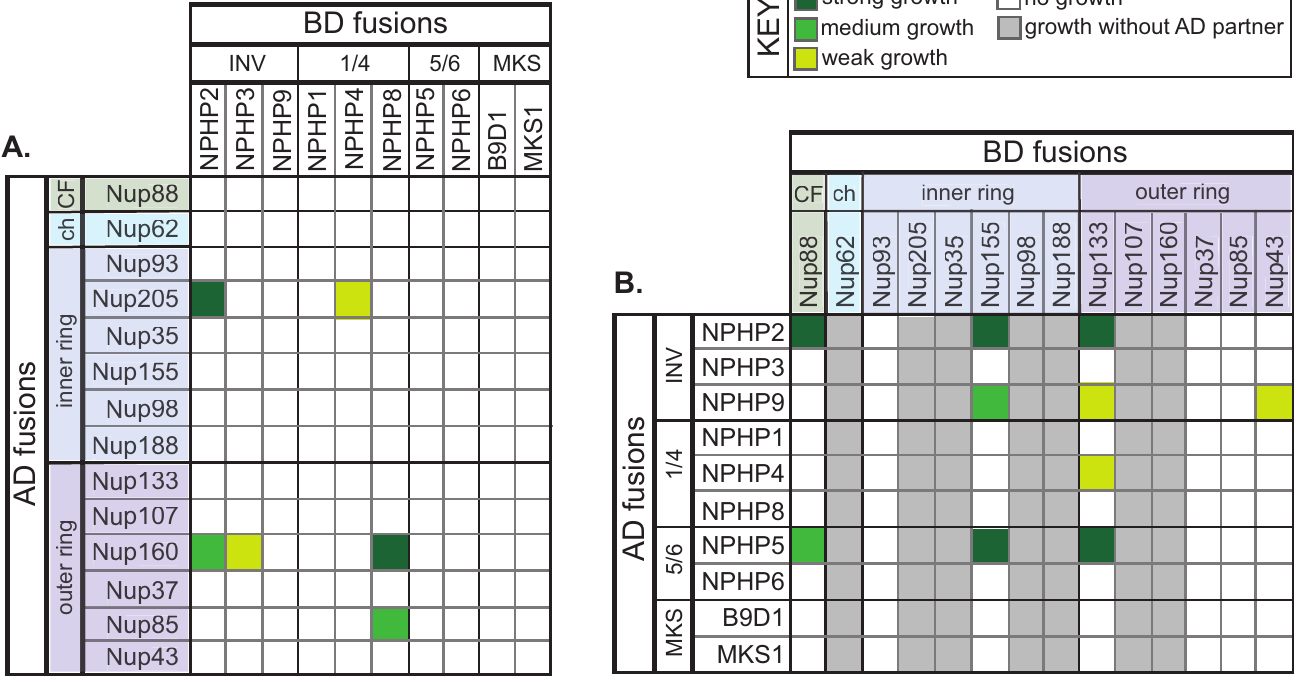
Fig 3. Directed yeast two-hybrid assay reveals NUP-NPHP interactions. The indicated transition zone proteins (INV, NPHP1/4, NPHP5/6, MKS complexes) and nucleoporin proteins were fused to a DNA binding domain (BD) or transcription activation domain (AD). Yeast of different mating types were mated pairwise to test for protein-protein interactions. Transcriptional activation allowing growth of diploid yeast was observed after 3 days and scored as strong growth (dark green), medium growth (medium green), or weak growth (yellow-green). Each pairwise mating was repeated at least three times. CF, cytoplasmic filament nucleoporin. ch, central channel